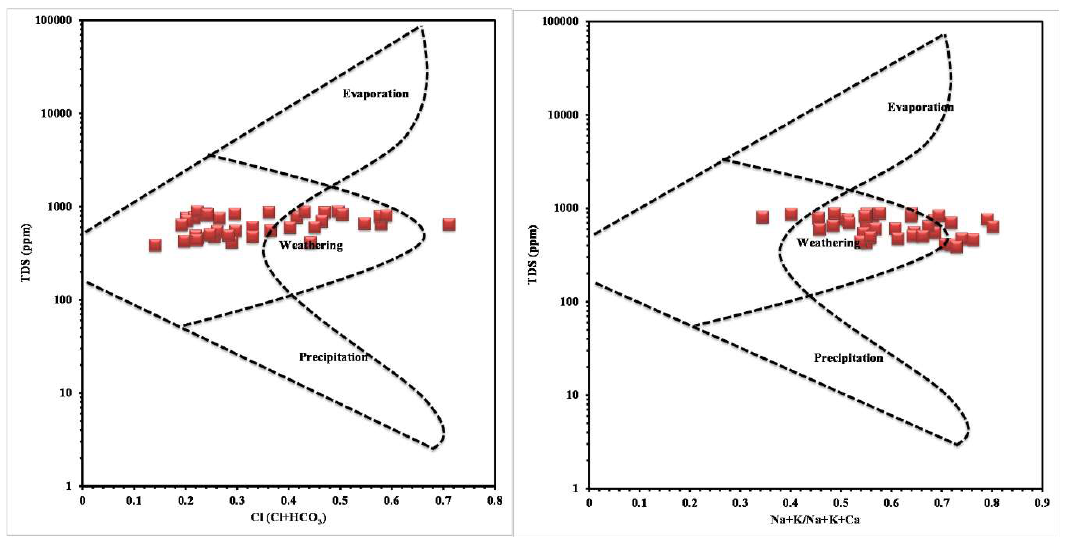
Figure 4. Piper plot. Geosciences 2019 , 9 FOR PEER REVIEW